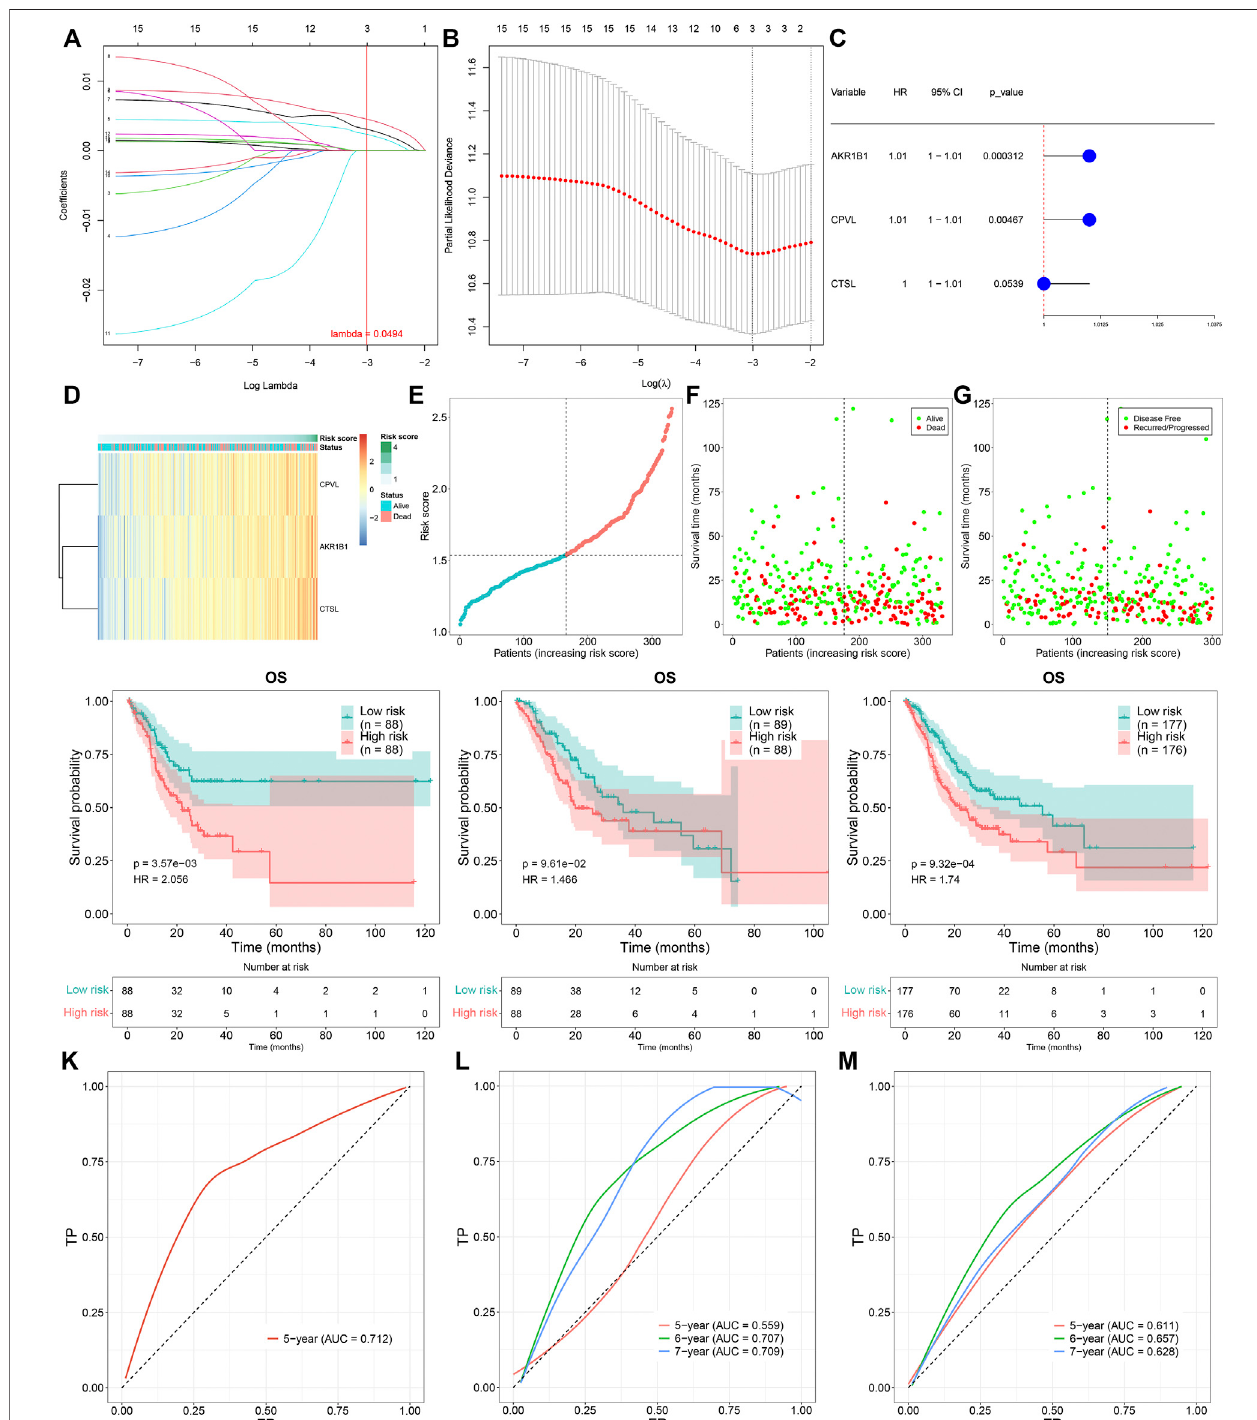
FIGURE2 | Construction of aTNF α -derived gene signature for prediction ofGC prognosis. (A) LASSO coef fi cient pro fi ling ofprognostic TNF α -derived genes. The redline indicated the value determined by three-fold cross-veri fi cation. (B) Tuning parameter selection for the LASSO model. The partial likelihood of deviance was depicted against log( λ ),inwhich λ wasthe tuning parameter. Apartiallikelihooddeviance valuewasdisplayed,and error bars representedSE. Adotted vertical linewas drawnattheoptimalvaluethroughminimumand1-SEcriteria. (C) UnivariatecoxregressionanalysesoftheassociationsofGCprognosisandcharacteristicTNF α - derivedgenes. (D) HeatmapvisualizingtheexpressionsofcharacteristicTNF α -derivedgenesinhigh-andlow-riskgroups. (E) DistributionoftheTNF α -derivedriskscore acrossGC patients. Theverticaldotted linerepresented thegrouping cutoff. (F) Distributionofthe survival status (alive and dead) among GC patients. (G) Distributionof the recurred and progressed status among GC patients. (H – J) Kaplan – Meier curves ofOS outcomes for high- and low-risk GCpatients inthe (H) training set, (I) testing set, and (J) entire set. (K – M) ROC curves at 5-year, 6-year, and 7-year survival based on TNF α -derived risk scores in (K) training, (L) testing, and (M) entire sets.